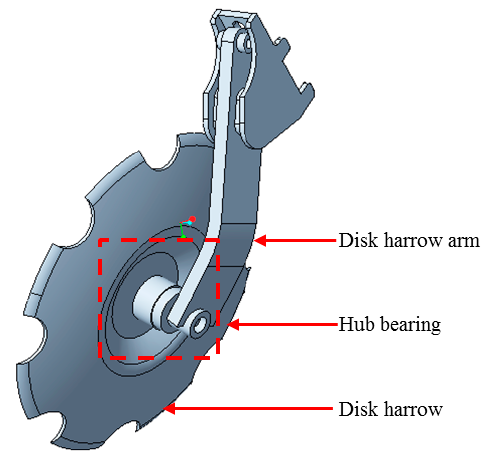
Figure 1. Structure of composite working implements.